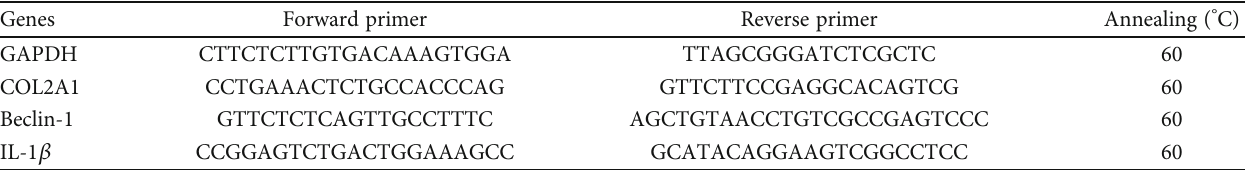
Table 1: Oligonucleotide primers used for